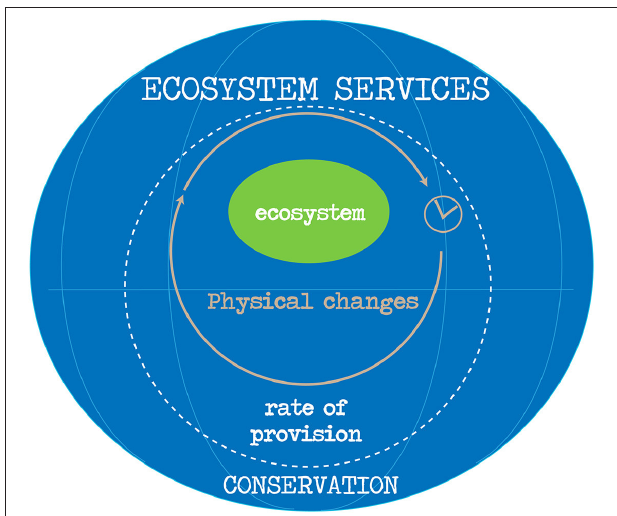
FIGURE 2 | A framework for ecosystem service analysis based on physical changes through time and space; the dashed white line in this figure limits the conservation dimension that should be taken into account alongside temporal variability in physical changes (brown line coupled with a clock symbol) for a certain ecosystem (green